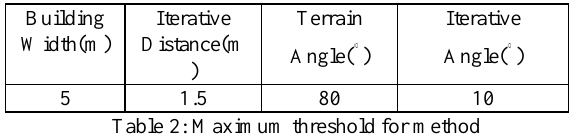
Table 2: Maximum threshold for method